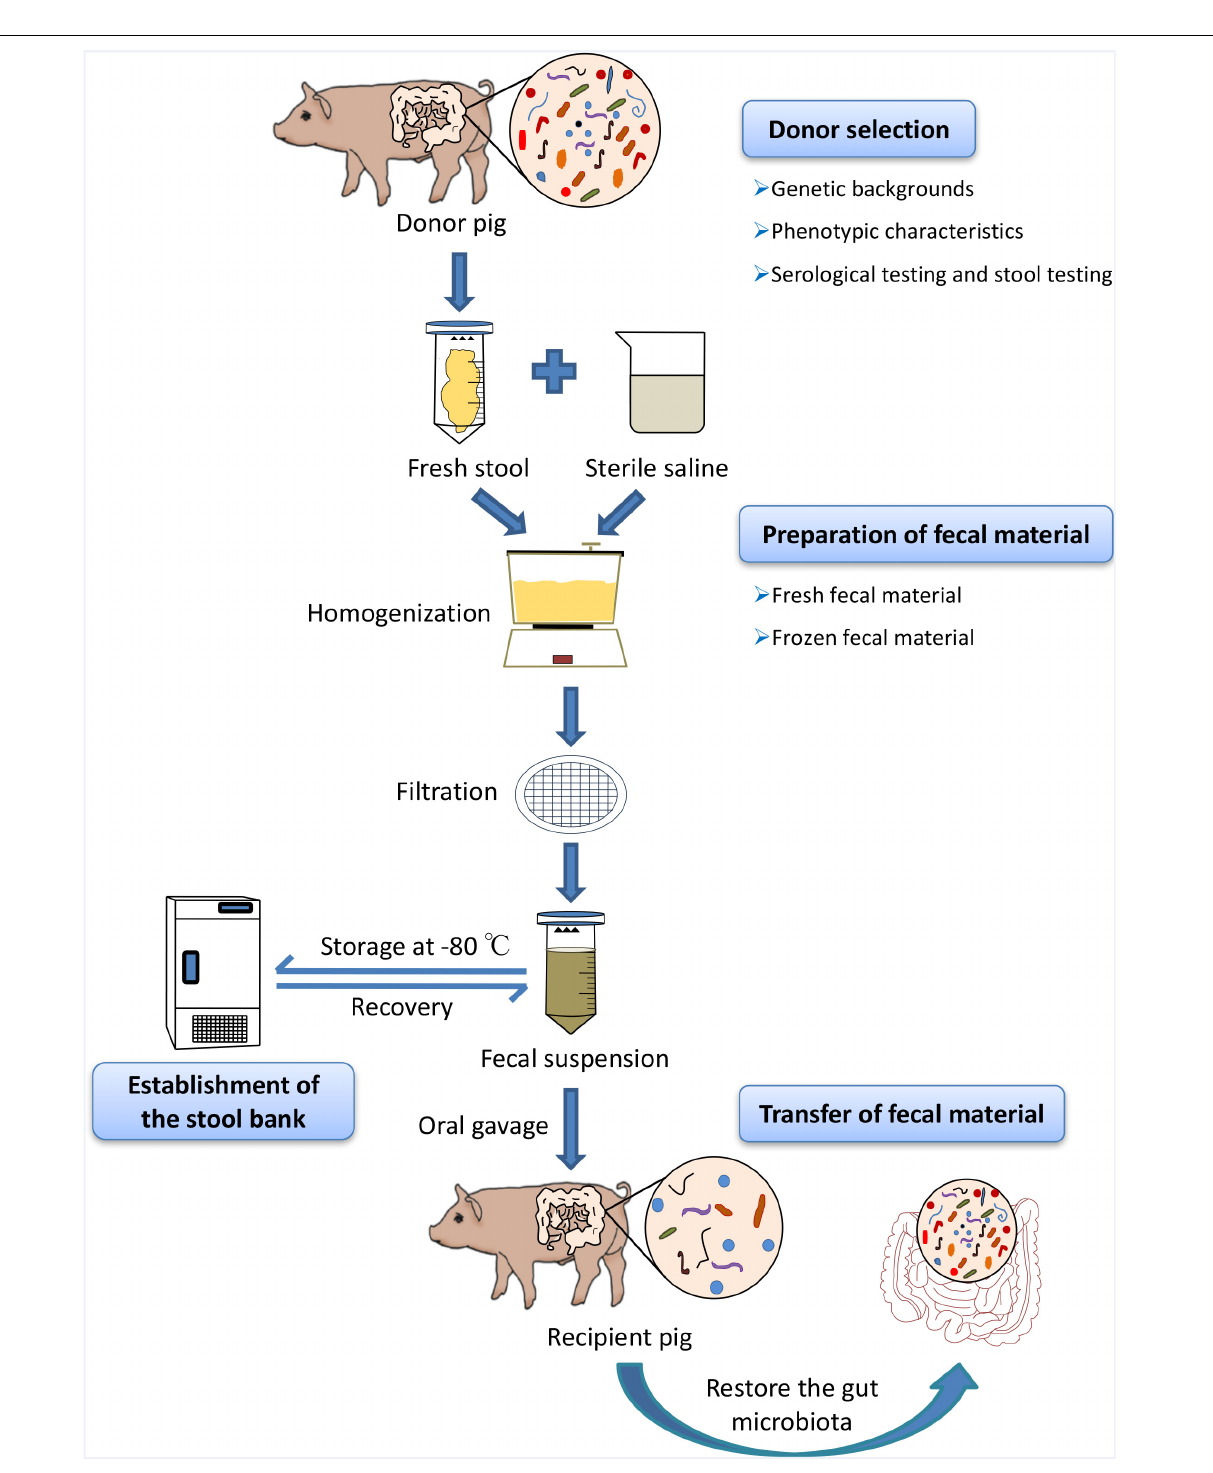
Frontiers in Microbiology |